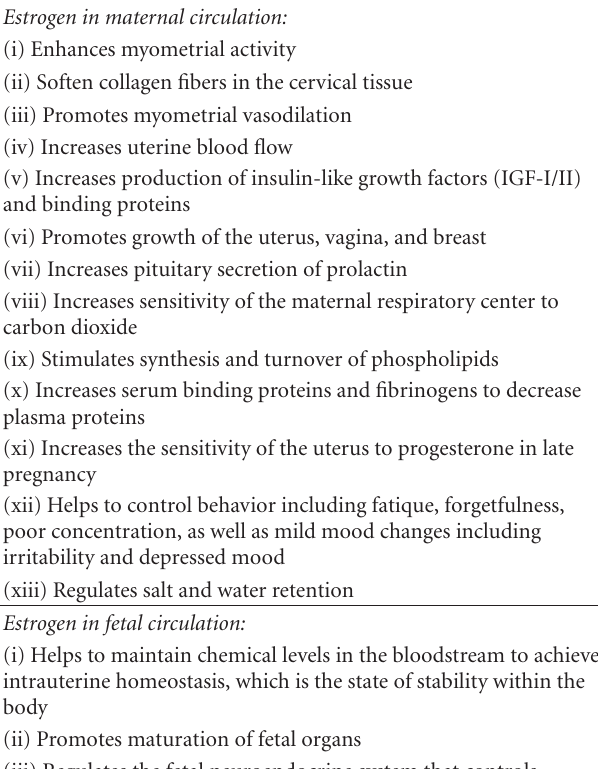
Table 1: The e ff ects of estrogen on the mother and the fetus. Estrogen in maternal